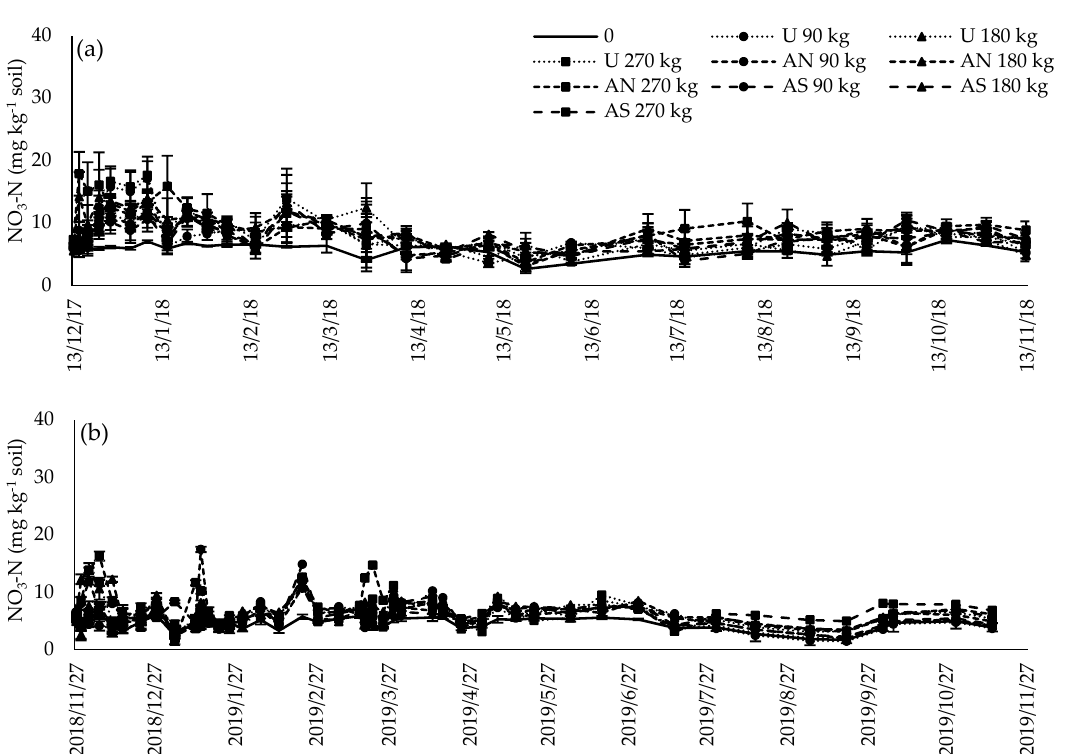
Figure 7 . Descriptive averages of NO 3 –N content of soil (mg NO 3 –N kg − 1 of dry soil). Experiment 1 ( a ) and 2 ( b ).